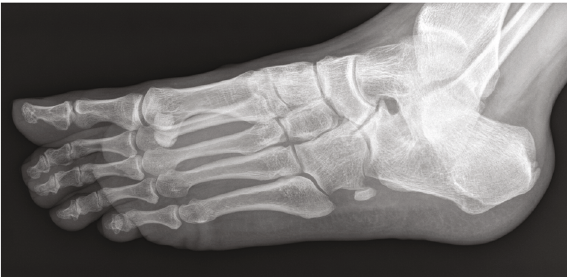
Figure 2: Oblique x-ray image of the left foot shows irregularity of the cubonavicular and calcaneonavicular articular surfaces with sclerotic